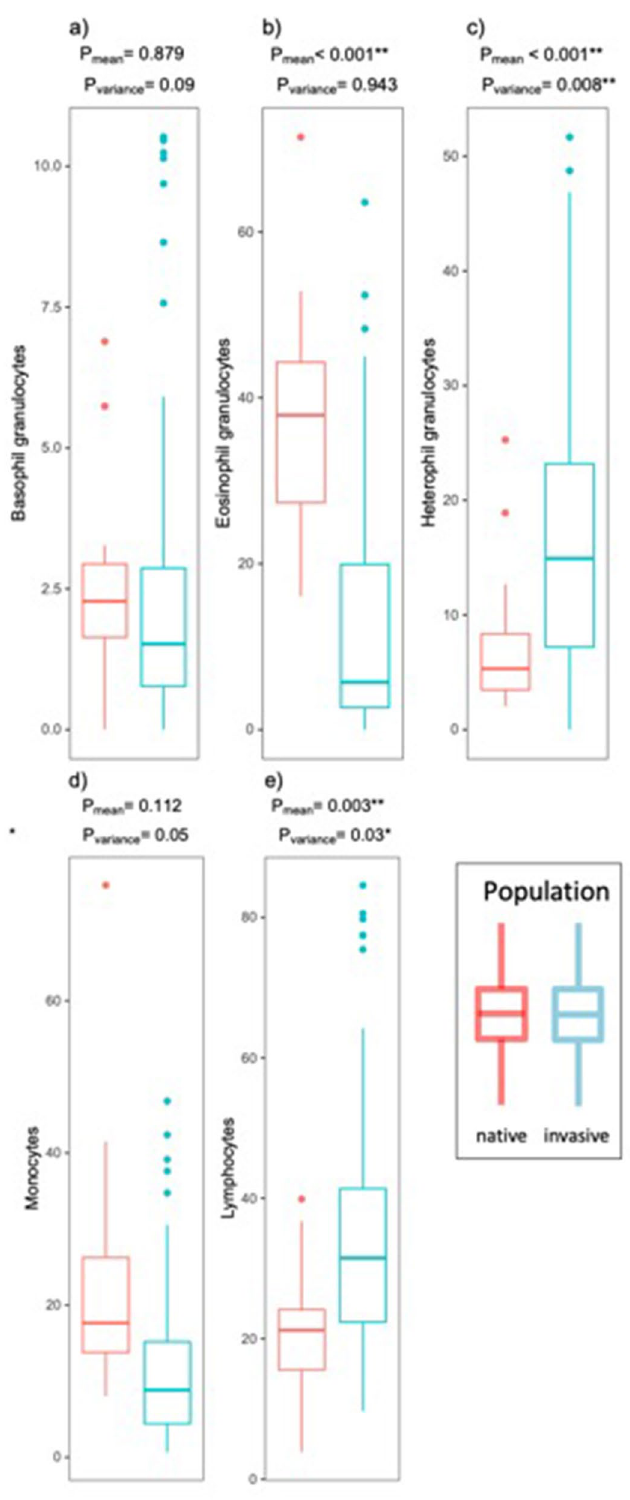
Figure 2. Differences in distributions of the differential white blood cells (nr per 10 4 erythrocytes) ( a – e ) between native and invasive Egyptian geese are shown; red = native; blue = invasive; P = p -values for the effects of population (native vs. invasive) on the mean (P mean ) and variance (P variance) of the respective immune measure from the GLMMs (see Table S5). For sample sizes of each immune measure for the two populations see Table